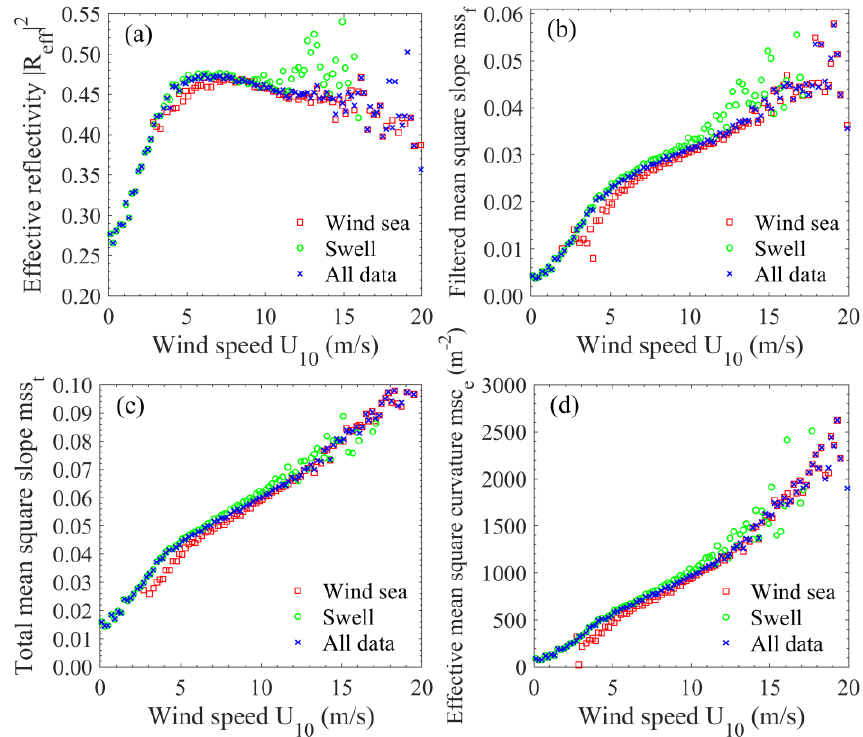
Figure 15. Radar-estimated ( a ) effective reflectivity | R eff | 2 , ( b ) filtered mean square slope mss f , ( c ) total mean square slope mss t , and ( d ) effective mean square curvature msc e as functions of wind speed. Red squares correspond to the satellite/buoy data acquired during conditions of wind sea (pure wind and wind wave dominant seas); green circles correspond to the data acquired during conditions of swell sea (pure swell and swell dominant seas), and blue crosses correspond to all the satellite/buoy data.